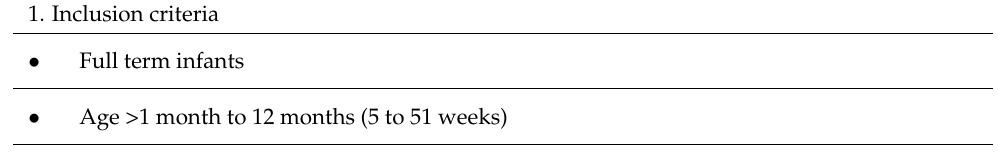
Table 1. Inclusion and exclusion